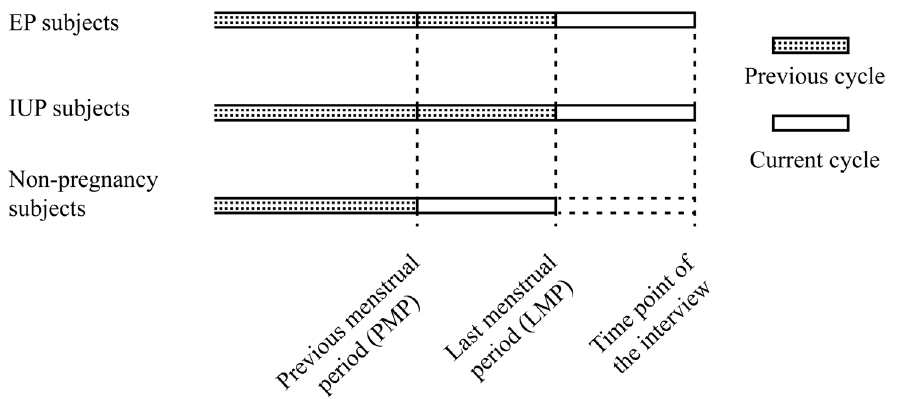
Figure 1. The definition of previous cycle and current